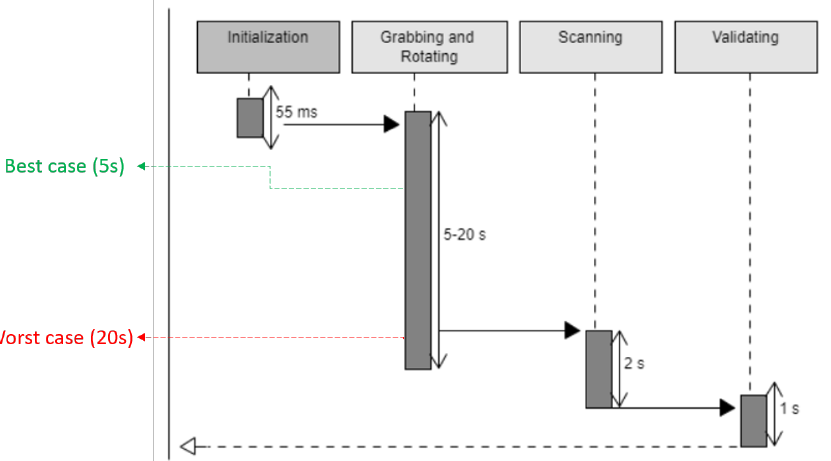
Figure 23. Execution time of the full process.